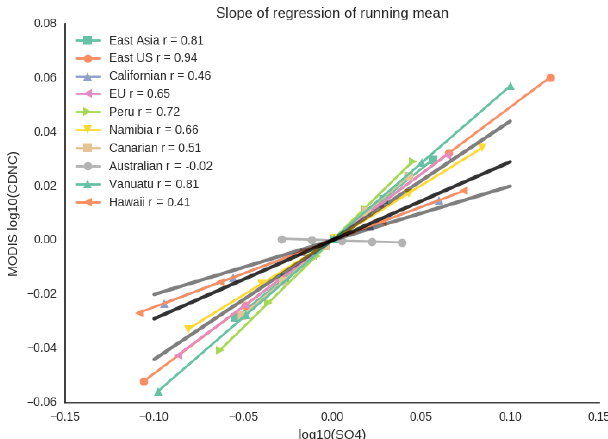
Figure 6. An illustration of the slope of the linear regression of re- gionally and temporally averaged log 10 SO 4 on log 10 CDNC. Both CDNC and SO 4 are averaged in each region and smoothed with a 365-day moving average (see Fig. 5). Each region is noted in the legend along with the correlation between log 10 CDNC and log 10 SO 4 . The × range of the lines corresponds to the range of regionally and temporally averaged log 10 SO 4 in each region. Slopes derived from 1 ◦ × 1 ◦ daily data in the stratocumulus regions are shown us- ing black and gray solid lines. The mean coefficient from the stra- tocumulus regions (Table 1) is shown as a black line. The minimum and maximum coefficients from the stratocumulus regions (Califor- nia and Australia, respectively) are shown as solid gray